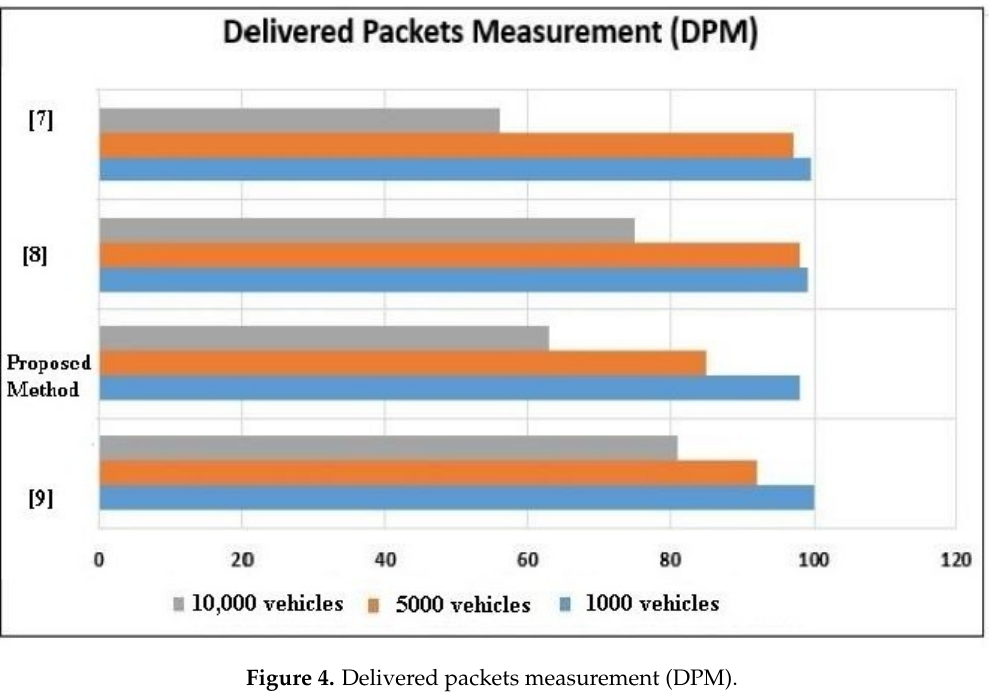
Figure 4. Delivered packets measurement (DPM).